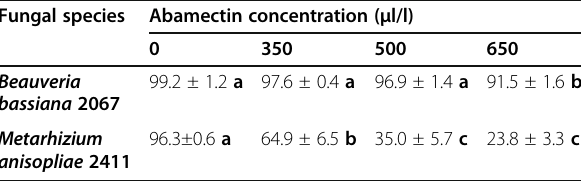
Table 4 Viability (germination percentage) of the spores according to the different treatments with copper oxychloride Fungal species